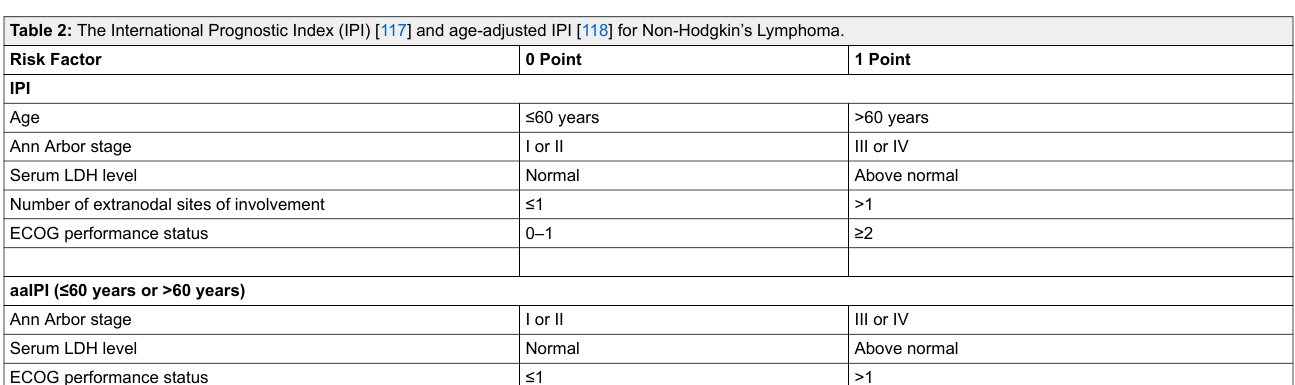
Table 2: The International Prognostic Index (IPI) [117] and age-adjusted IPI [118] for Non-Hodgkin’s Lymphoma. Risk